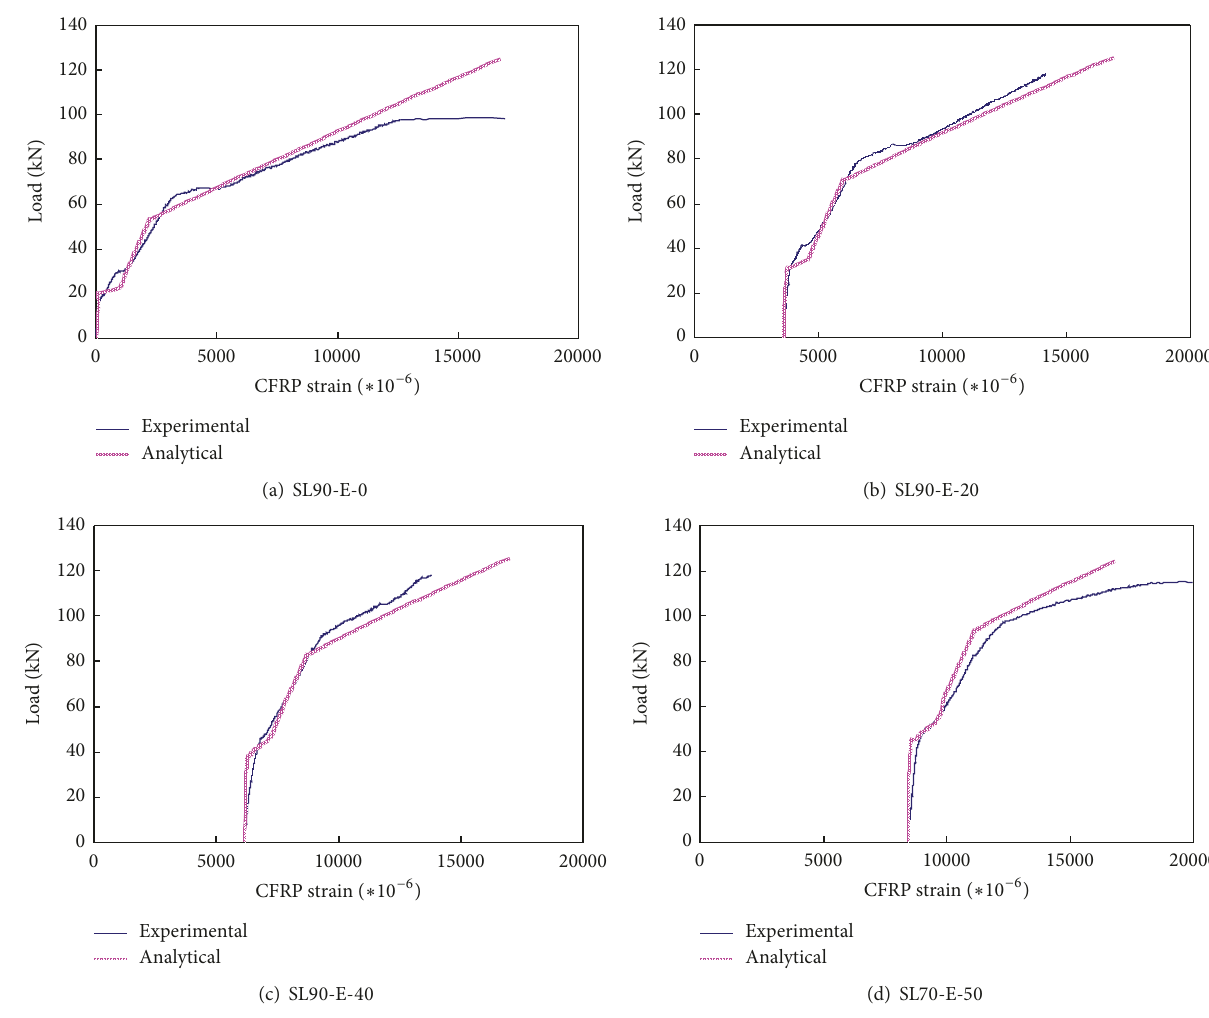
Figure 12: Comparison of experimental and analytical load-strain